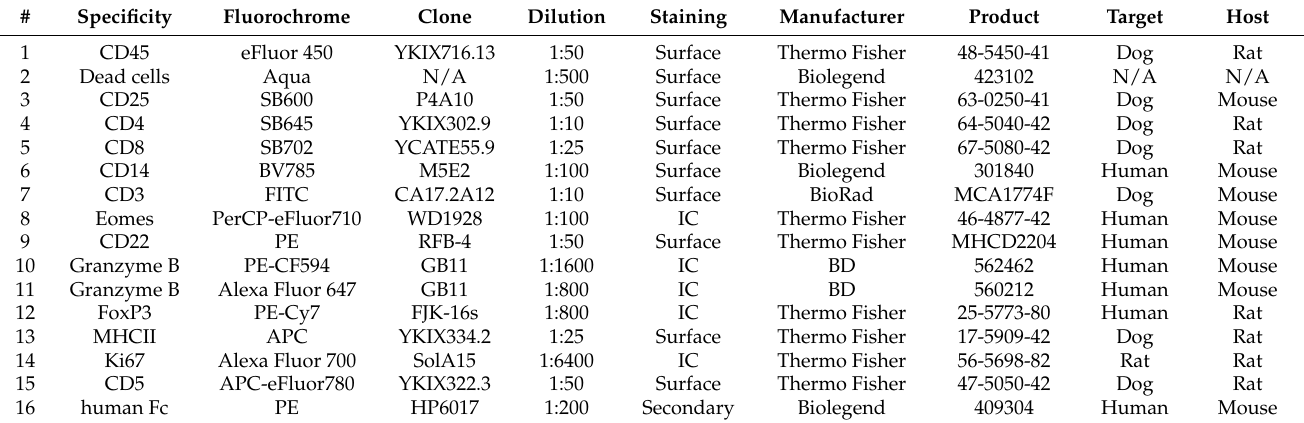
Table 1. List and details of flow cytometric antibodies used in this